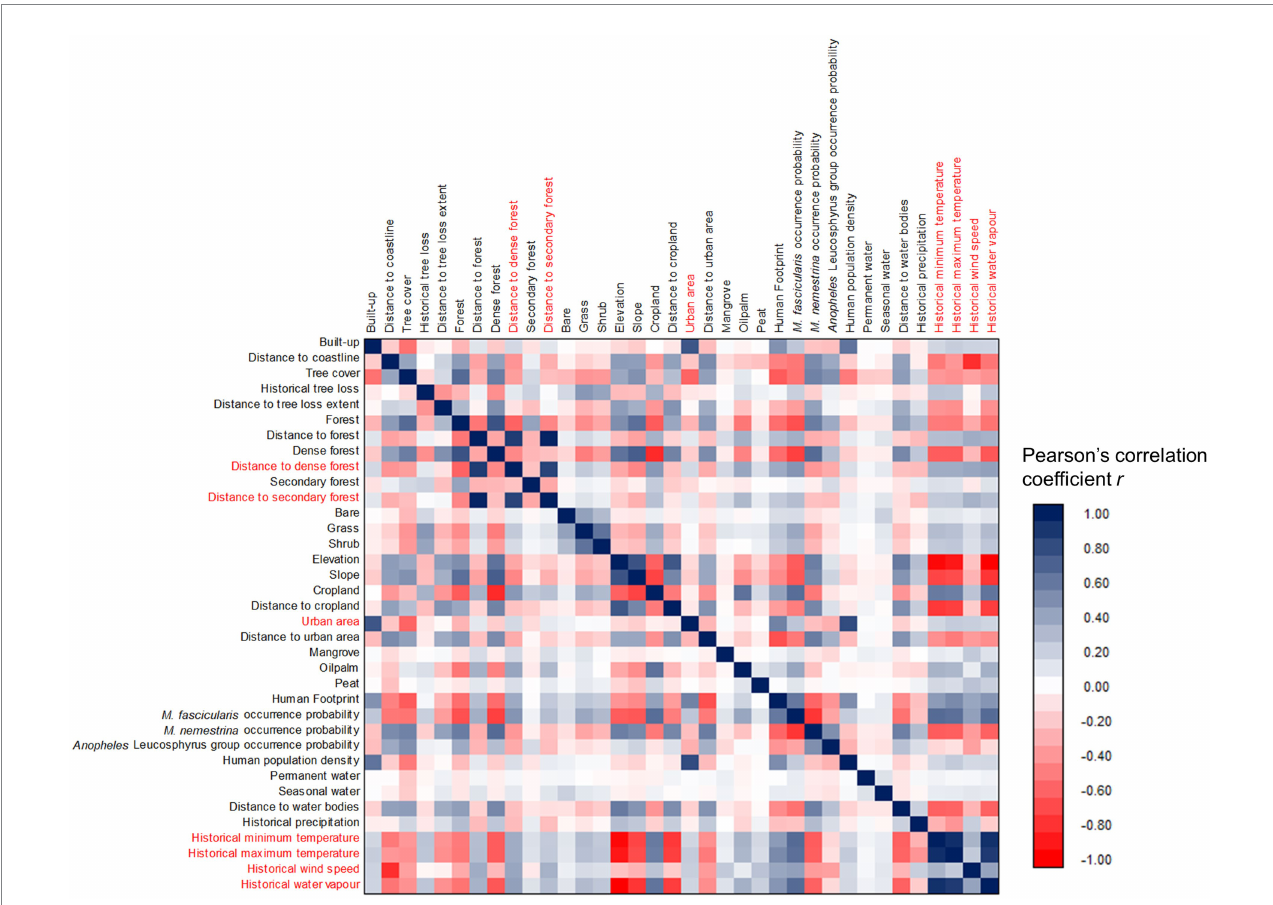
FIGURE 3 Correlation matrix of all spatial covariates. Covariates highlighted in red indicated high collinearity ( r ≤ − 0.8 or ≥ 0.8) with at least one of other covariates were removed from the modeling